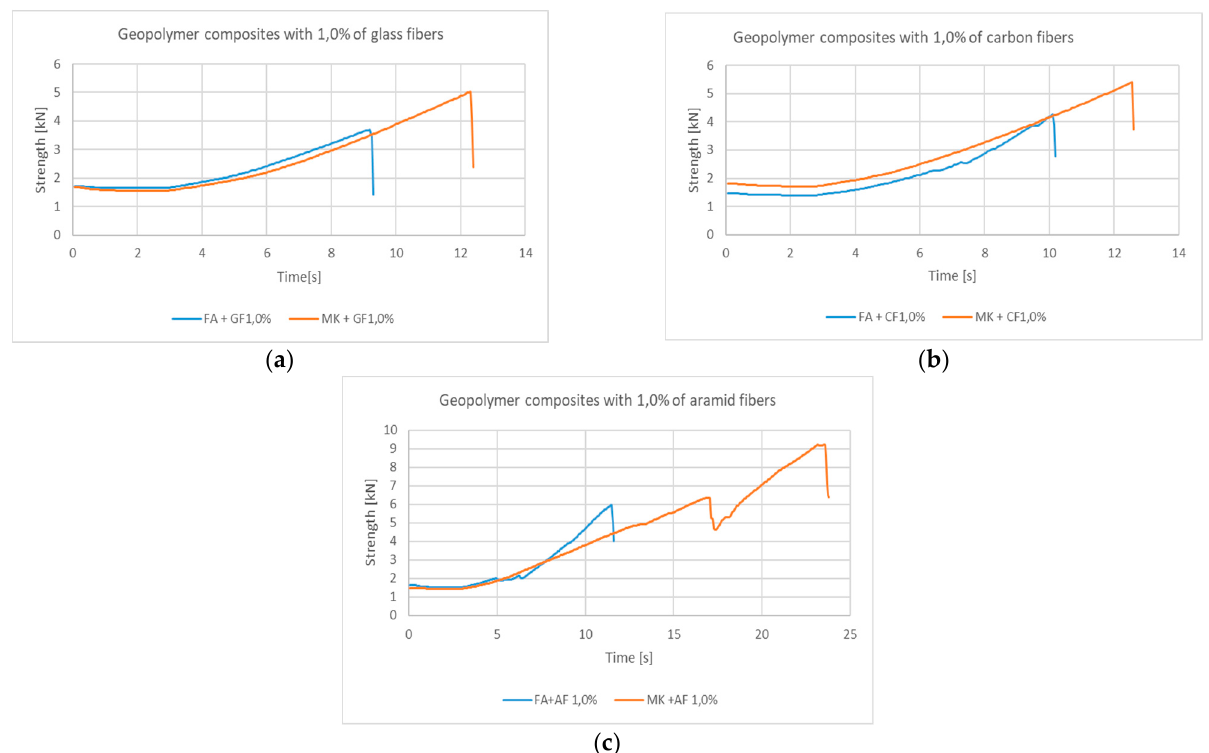
Figure 6. Strength–time comparison of the behavior of composites based on fly ash and metakaolin with the addition of 1.0% roving from: ( a ) glass fiber; ( b ) carbon fiber; ( c ) aramid fibers.